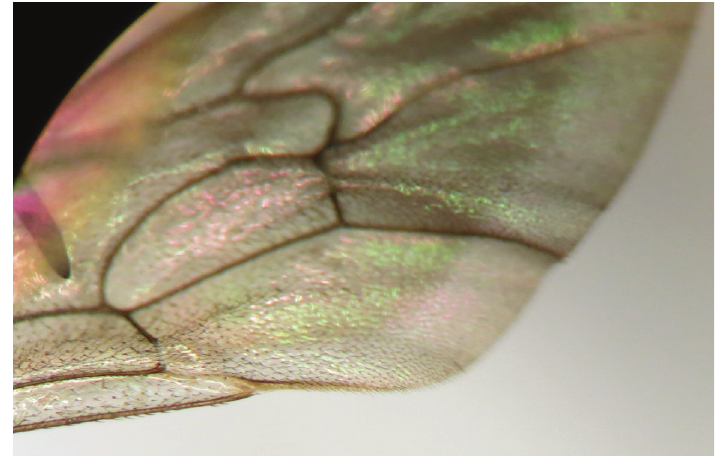
Figure 15. Heinrichiella obscura comb. n., part of fore wing with spurious vein (France).